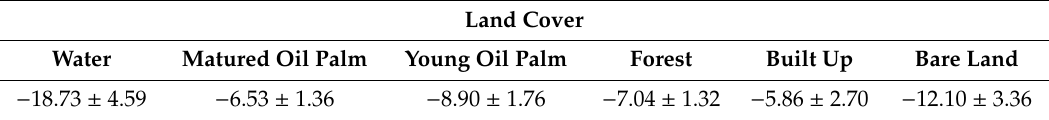
Table 3. Average backscattering values (dB) for various land cover / land use types derived from horizontal–horizontal (HH) polarization of ALOS PALSAR radar